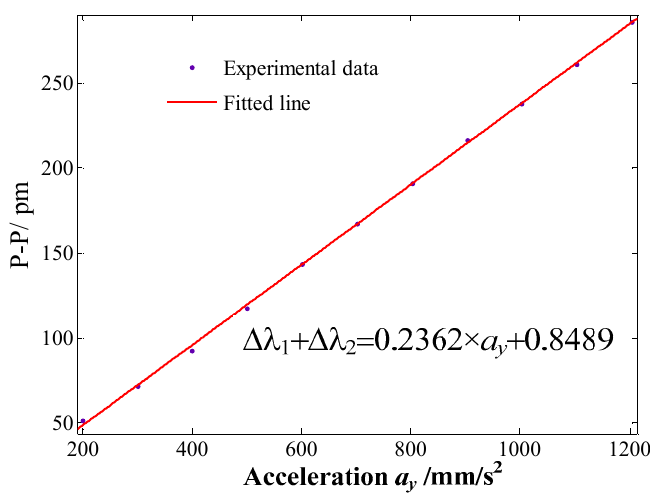
Figure 7. The linear fitting curve of addition value Δλ 2 + Δλ 1 versus applied acceleration a y .